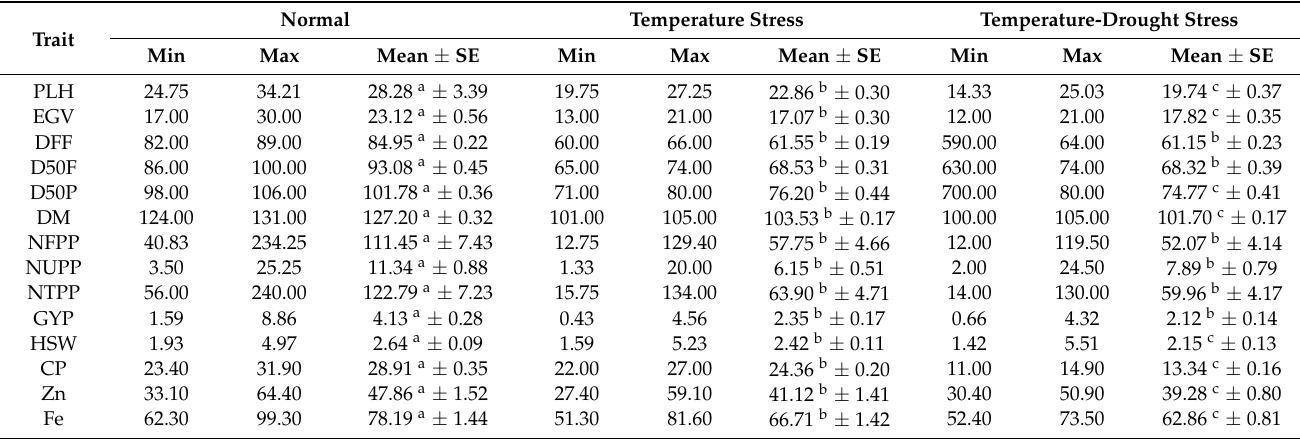
Table 1. Minimum, maximum and mean morphological parameters of 20 lentil genotypes under normal, temperature stress and temperature-drought stress